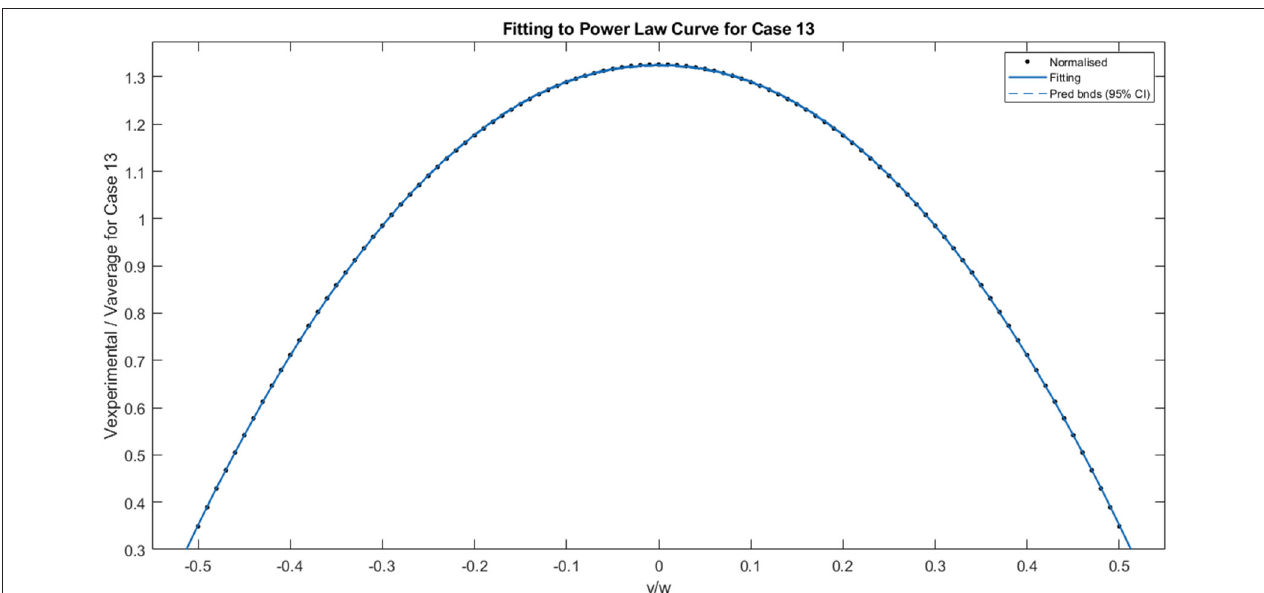
FIGURE 8 | Fitting of normalized velocity profile data to the power law curve for Case 13.